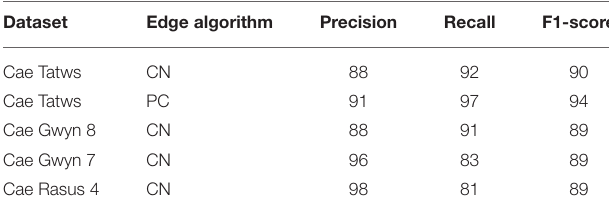
Frontiers in Plant Science |